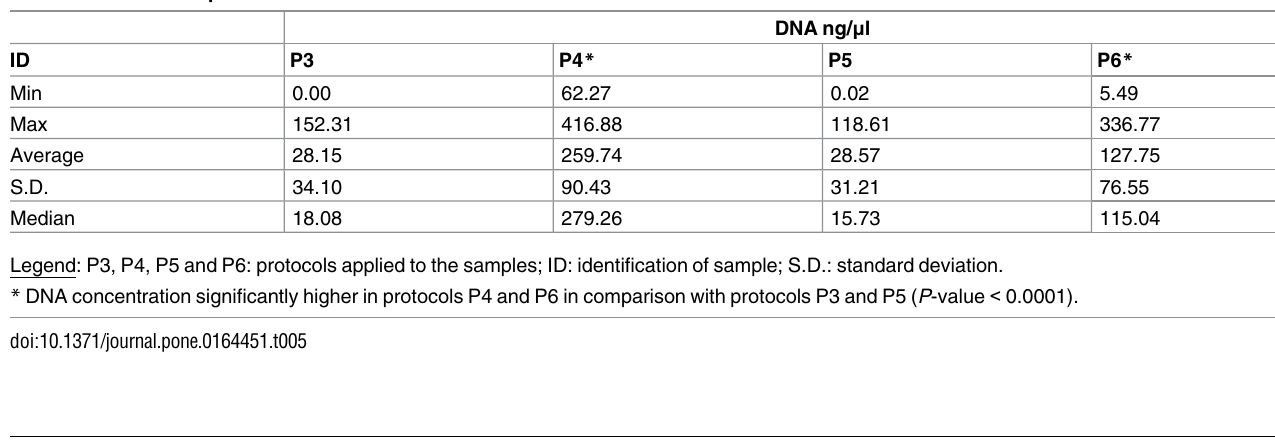
Fig 4. Kinetic of median optical density obtained with the Erns–based Ag ELISA in function of dilution of five positive referencesamples at three different time periods for each of the four different protocols used. Legend: P1, P2, P3, P4: protocols appliedto the samples; P1 and P3: no significant differencein function of time (two-factor ANOVA with repeated measures on one factor; P-value > 0.05); P2 and P4: significant difference in function of time (two-factor ANOVA with repeated measures on one factor; P-value < 0.05).